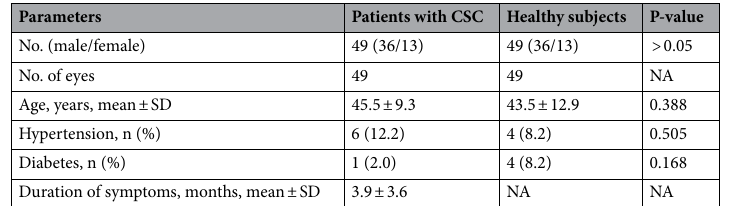
Table 1. Characteristics of patients with CSC and healthy subjects. CSC central serous chorioretinopathy, NA not applicable, SD standard deviation.